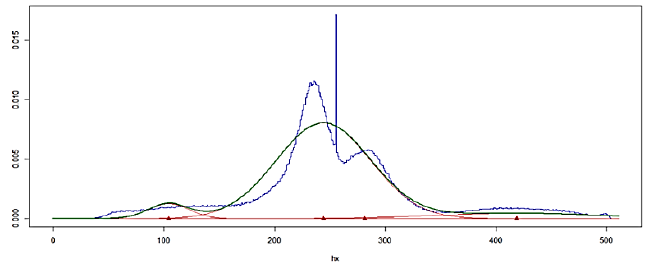
Figure 4.Difference image data modelling and estimating data distributions